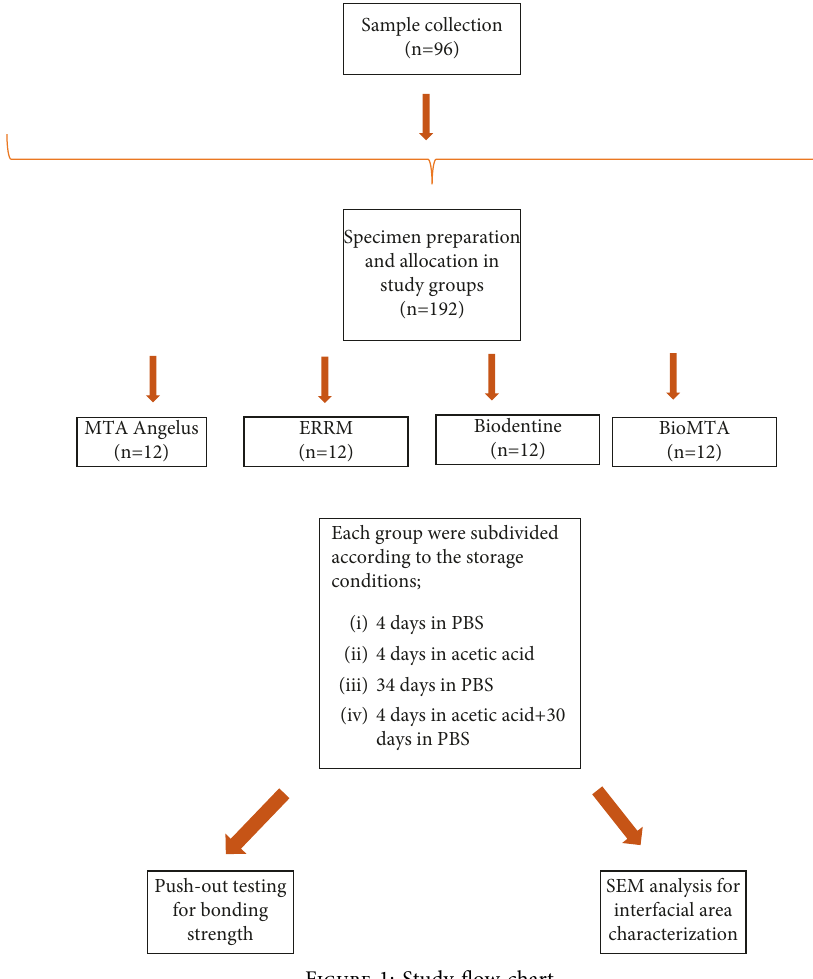
Figure 1: Study flow chart.